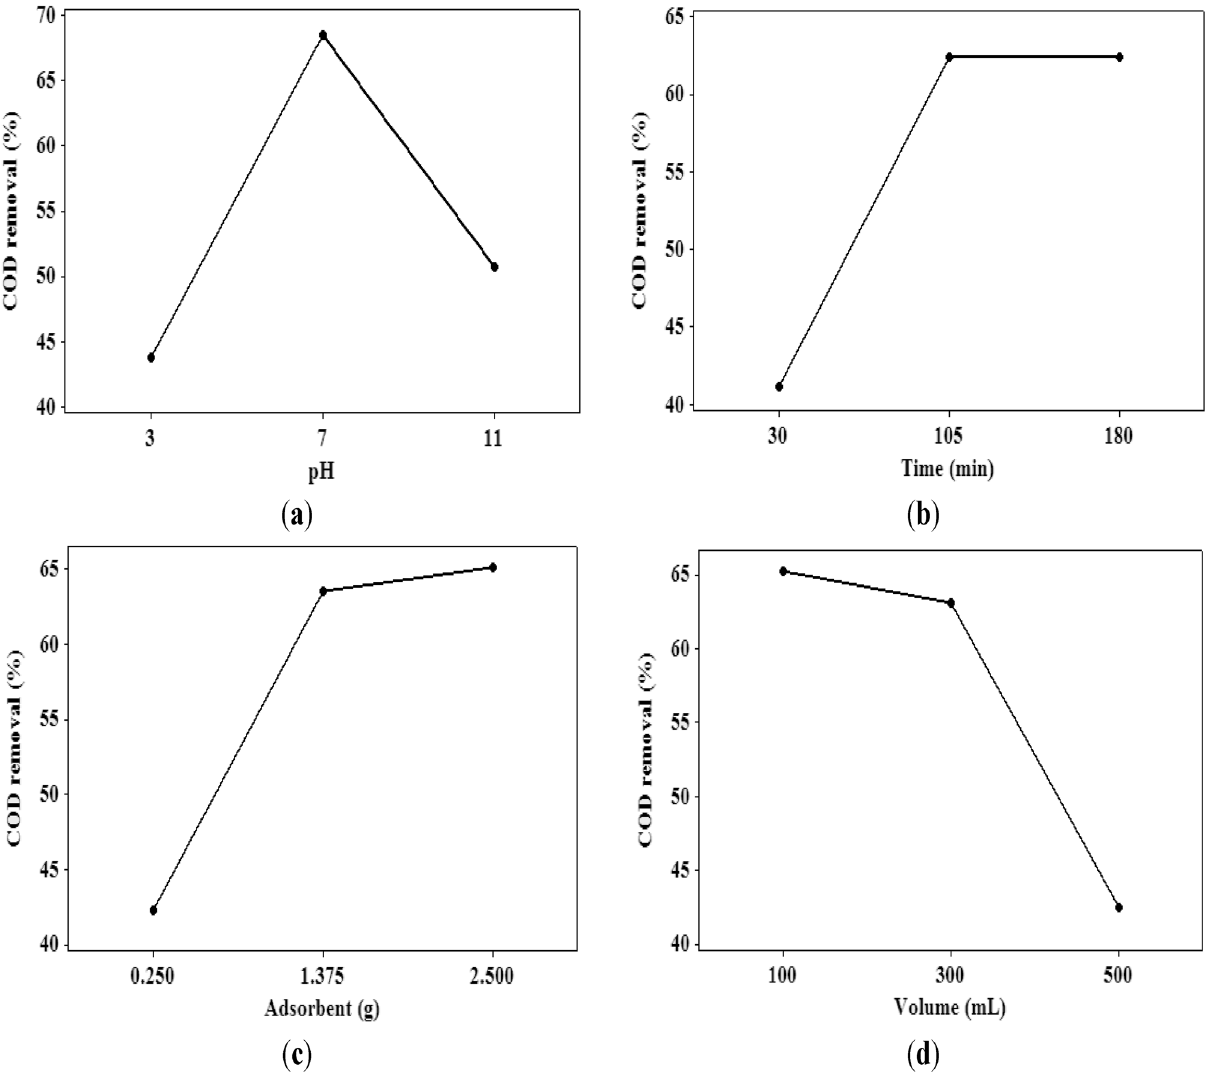
Figure 4. The influence of ( a ) solution pH, ( b ) wastewater-adsorbent contact time, ( c ) adsorbent content, and ( d ) solution volume on the COD removal ability of the TiO 2 –chitosan